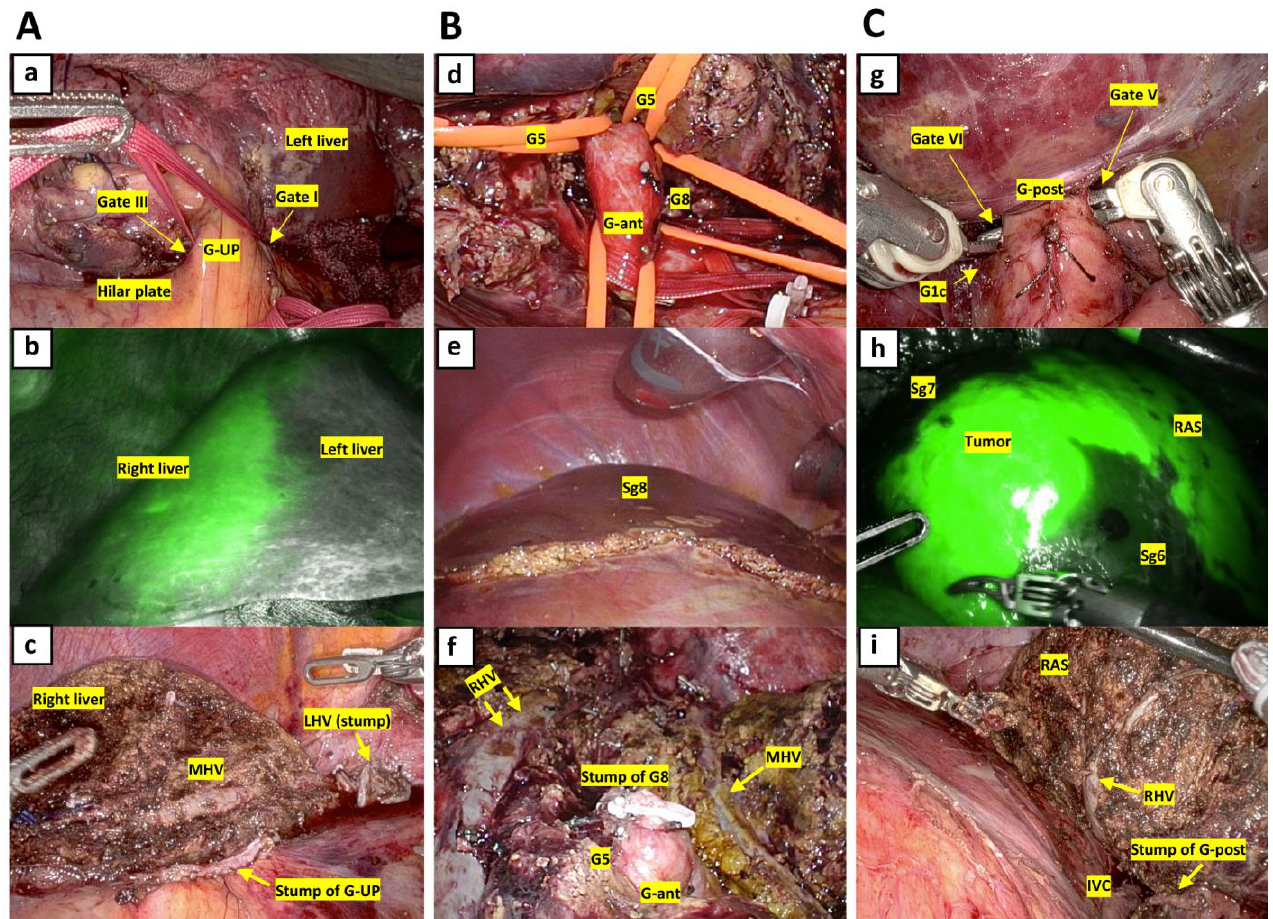
Figure 1. Anatomic liver resection using the extrahepatic Glissonian approach. ( A ) robotic left hemihepatectomy: ( a ) extrahepatic isolation of left Glissonian pedicle above the hilar plate (G-UP) by passing a tape between Gates I and III; ( b ) demarcation line between the right and left liver, using Firefly mode; ( c ) completion of left hemihepatectomy showing the exposed middle hepatic vein (MHV) and resected stumps of G-UP and left hepatic vein (LHV); ( B ) laparoscopic segmentectomy 8; ( d ) extrahepatic isolation of Glissonian pedicles of right anterior section (G-ant), Sg5 (G5), and Sg8 (G8); ( e ): selective isolated ischemia of Sg8; ( f ) completion of segmentectomy 8 showing the exposed MHV and right hepatic vein (RHV) and resected stump of G8; ( C ) robotic right posterior sectionectomy; ( g ) extrahepatic isolation of Glissonian pedicle of right posterior section (G-post); note Gates V and VI and caudate process pedicle (G1c); ( h ): Firefly mode after clamping G-post and intravenous ICG injection; note positive staining of the tumor and right anterior section (RAS) and negative staining of Sg6 and Sg7; ( i ) completion of right posterior sectionectomy showing the exposed RHV, inferior vena cava (IVC), and the resected stump of